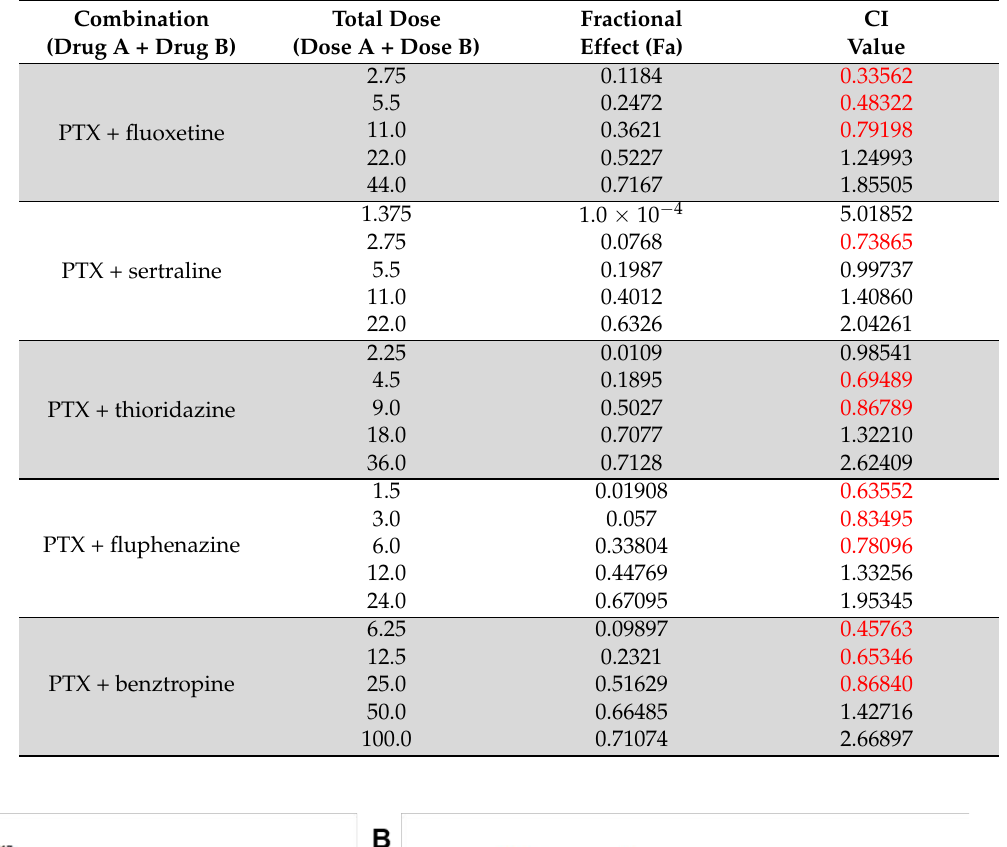
Table 6. CI values and respective fractional effect of different combinations of PTX plus CNS agents. CI in red indicates concentrations of drug pairs that are synergic. Cells were treated with 0.25, 0.5, 1, 2 and 4 times the IC 50 of each drug (total dose).